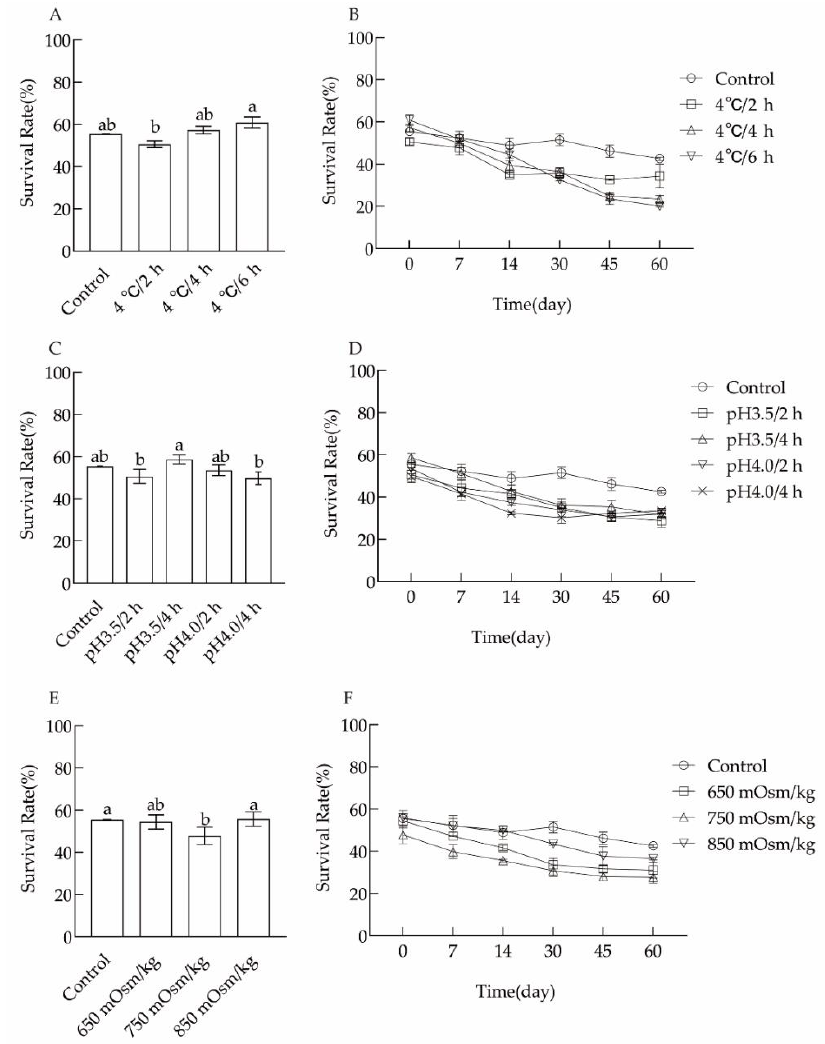
Figure 1. Effects of environmental stress on the lyophilization survival rate and storage of L. plantarum :